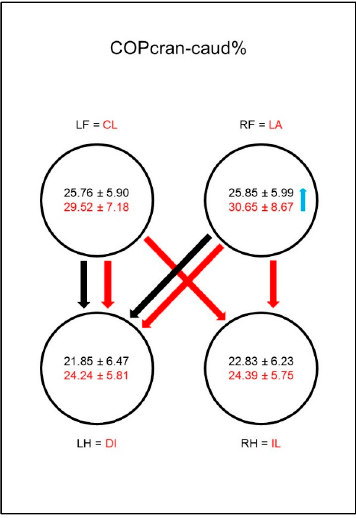
Figure 16. Cranio-caudal displacement of the center of pressure as a percentage of maximum length of paw contact area (COPcran-caud%) in study group 2 and control group. For detailed explanation and abbreviations refer to Figure 2. abbreviations refer to Figure 2.